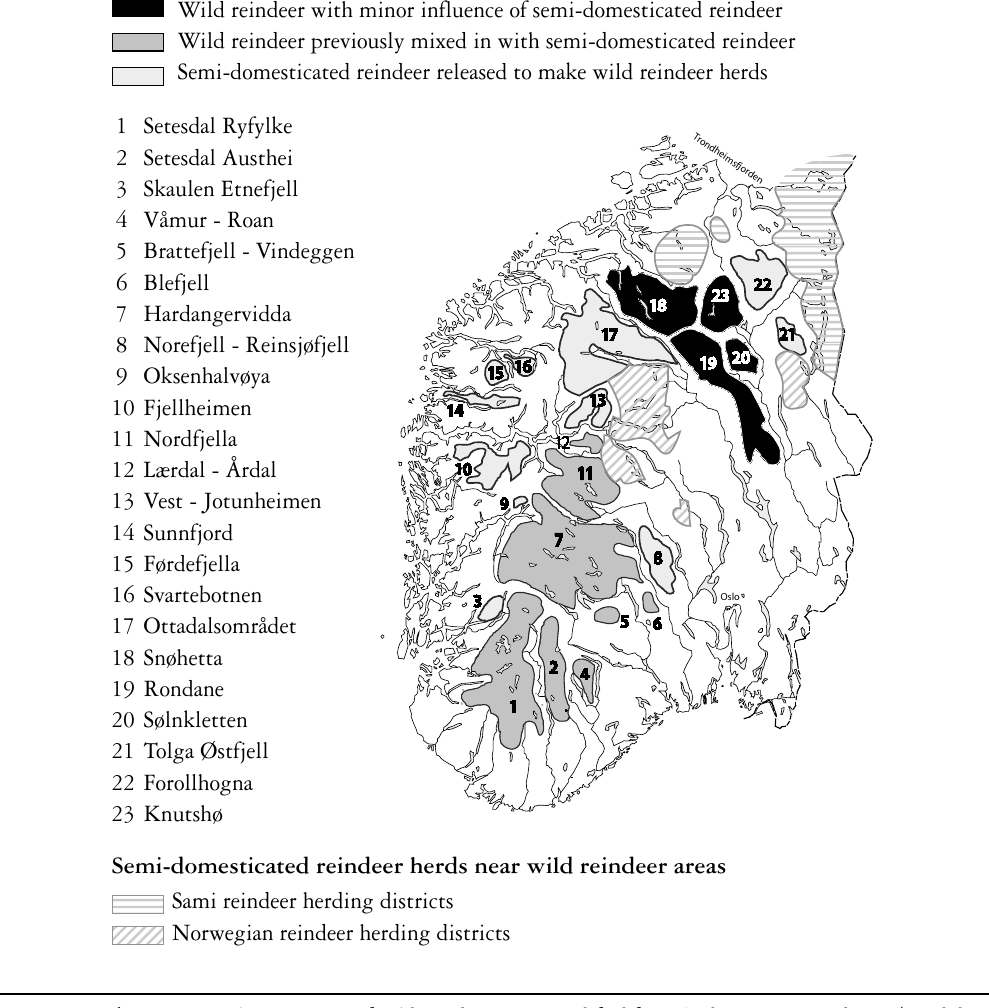
Fig. 1. Distribution in southern Norway of wild reindeer areas (Modified from Andersen & Hustad, 2004) and domes- ticated reindeer areas (Modified from Reindriftsforvaltningen,